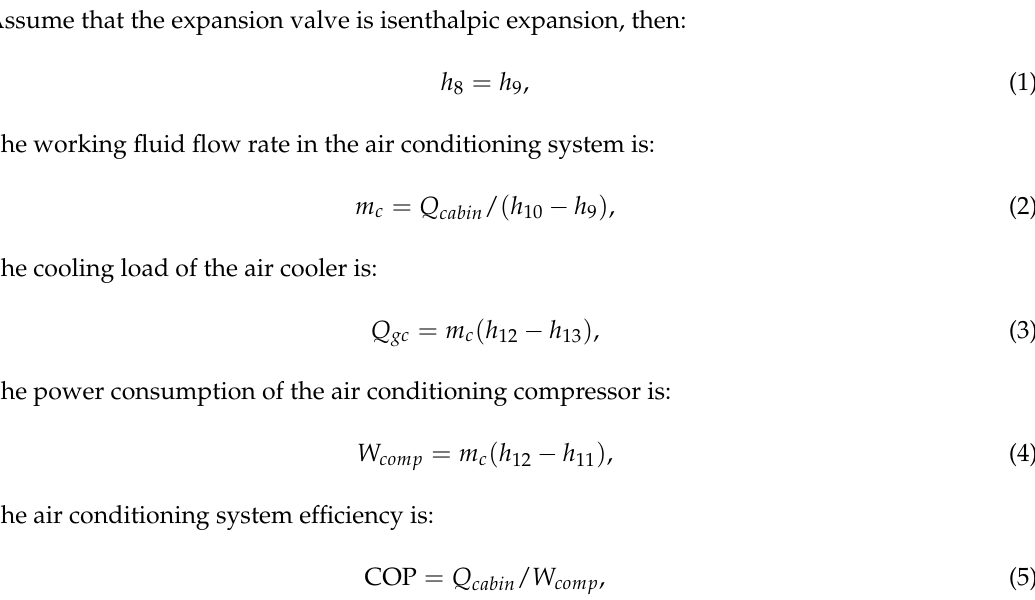
Figure 2. Schematic diagram of the air conditioning system.